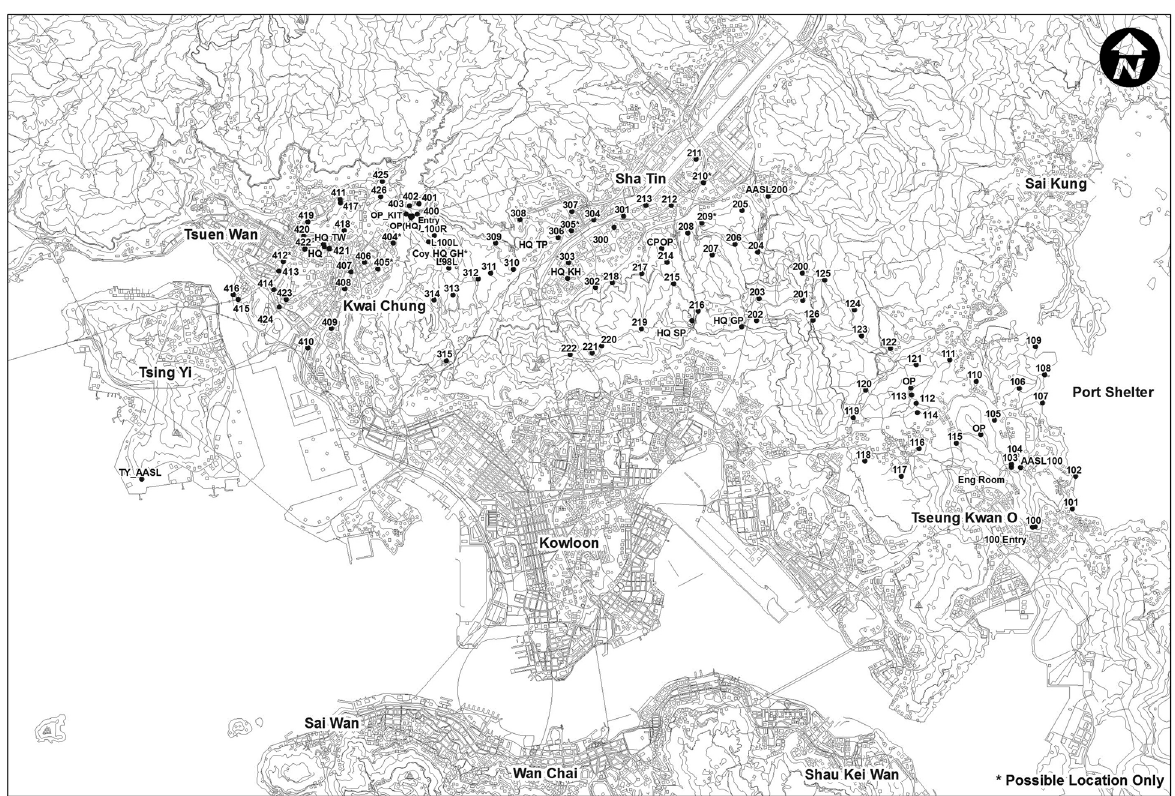
Fig. 7 Location of pillboxes and other structures of the Gin Drinkers ’ Line based on aerial photography (Source: Lai et al. 2009)